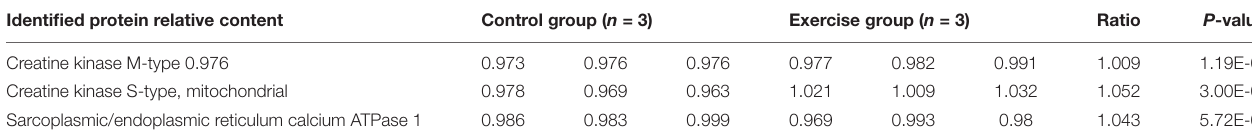
TABLE 3 | The expression of three enzymes in the gastrocnemius muscle.